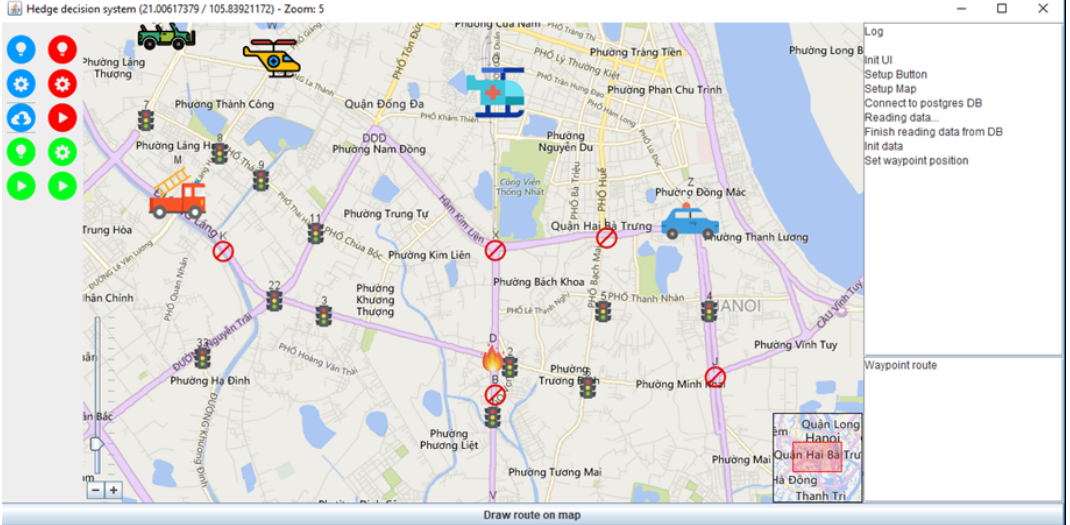
Figure 6. Initial vehicles with the proposed fire disaster appear on the Google